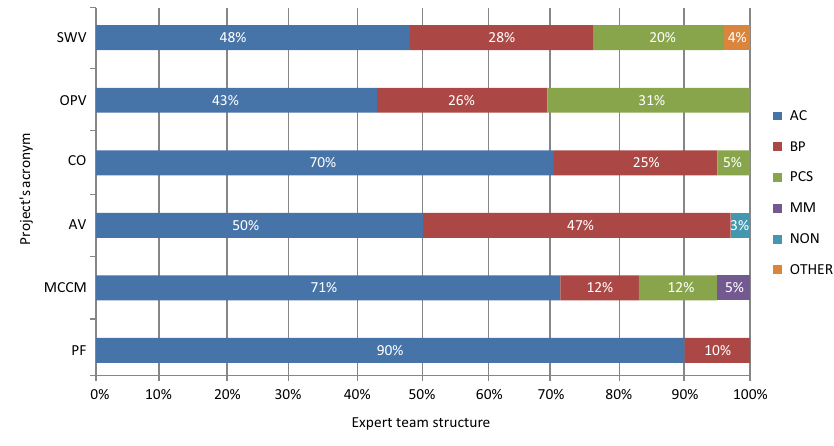
Fig. 3. Expert team structure engaged in scenario